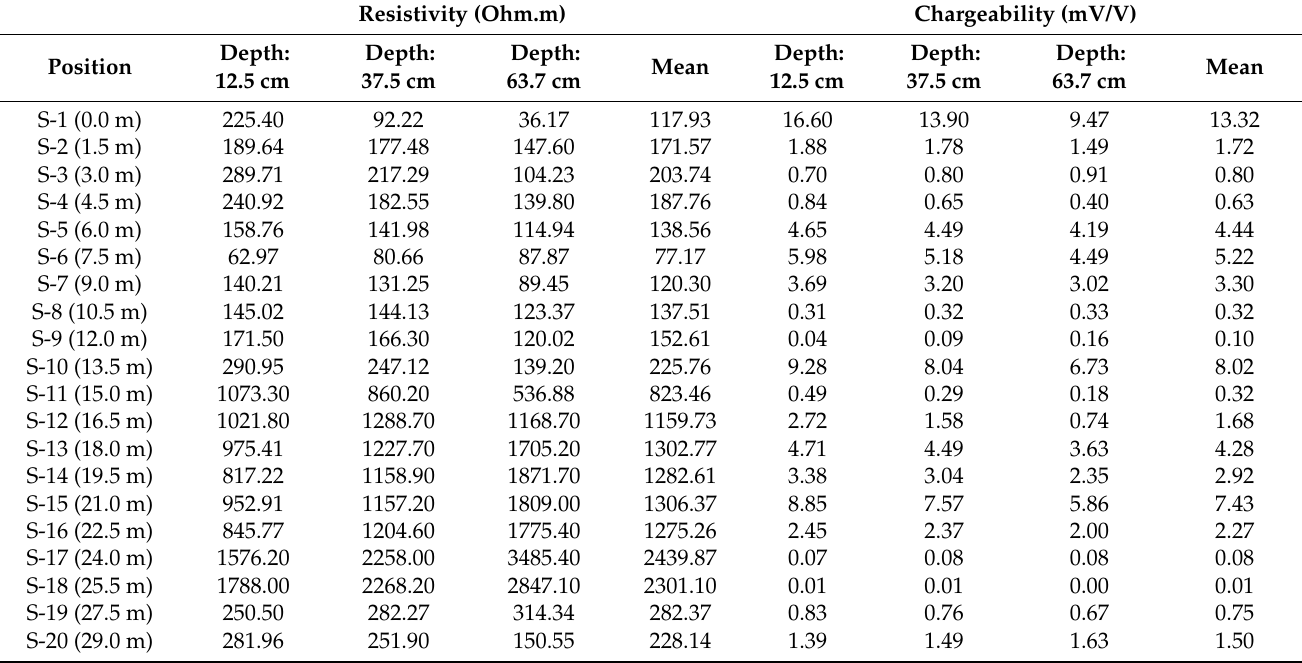
Table 1. Electrical resistivity and chargeability values measured at depths of 12.5 cm, 37.5 cm, and 63.7 cm along the slope of the Federico mine